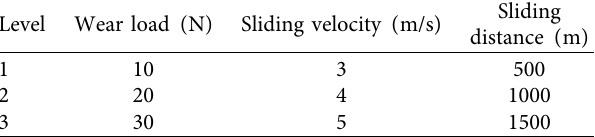
Table 4: Optimum factors and its levels.